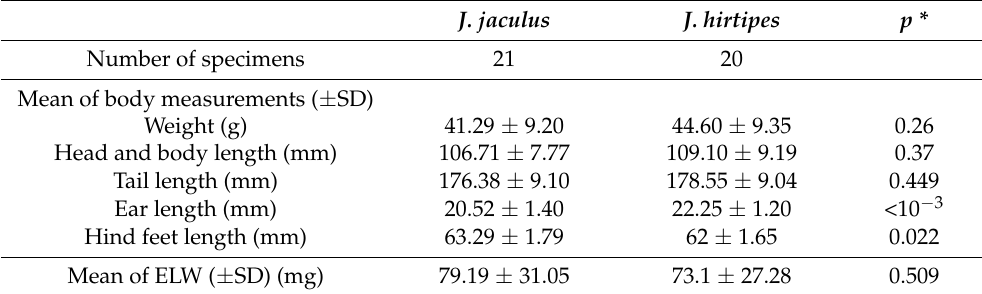
Table 2. Morphological measurements and eye lense weight (ELW) among Tunisian Jaculus jaculus and Jaculus hirtipes .